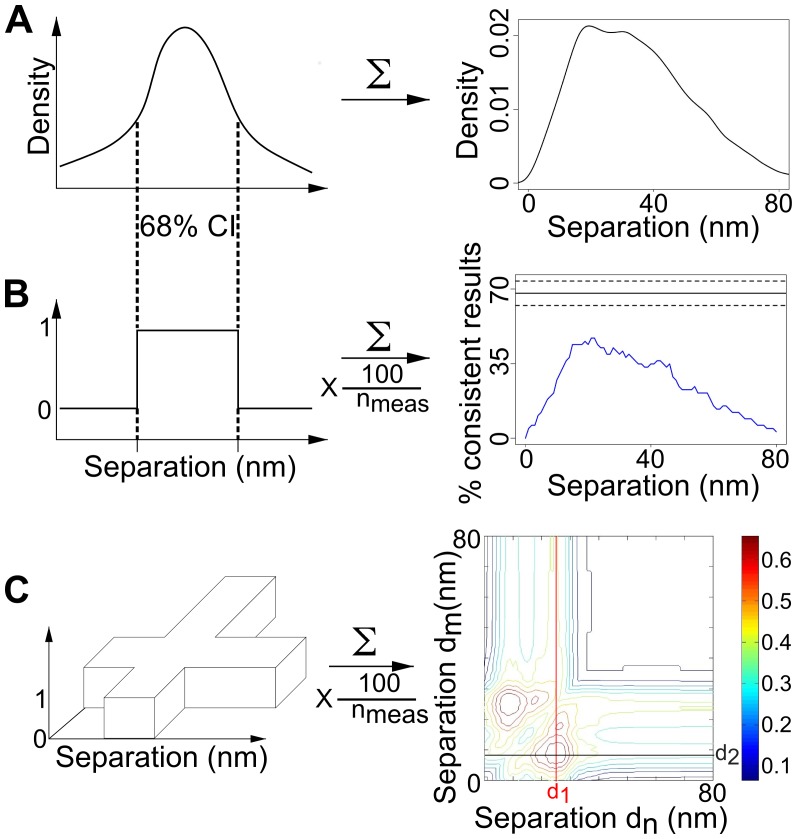
Using confidence intervals as diagnostics.(A) A sum of the individual bootstrap separation densities. The left-hand side shows a cartoon of the separation distribution of a single two-fluorophore spot. The right-hand side shows the distribution of the combined separation data from multiple two-fluorophore spots. (B) A 1sCI-Plot (right) is the scaled sum of top hat functions (left). Each top hat is created from the bootstrap separation distribution of a two-fluorophore spot. The top hat - or indicator - function has the value 1 if the separation lies within the 68% confidence interval, otherwise it has the value 0. The 1sCI-Plot plot (right) is an example sum of such functions for multiple two-fluorophore spots, where the scaling consists of dividing by the number of spots and then multiplying by 100 for a % scale. Hence, a value of 50% at a particular separation means that separation lies in the 68% confidence interval of the separation distribution of half of the two-fluorophore spots included in the analysis. The black line shows the ideal peak value (68%) expected for a repeated measurement of a single distance and the dashed lines show the uncertainty of this ideal due to the limited number of samples. (C) A 2sCI-Plot is the scaled sum of crosses, all with the same height and with equal arm widths given by the 68% confidence limits of each individual bootstrapped separation.